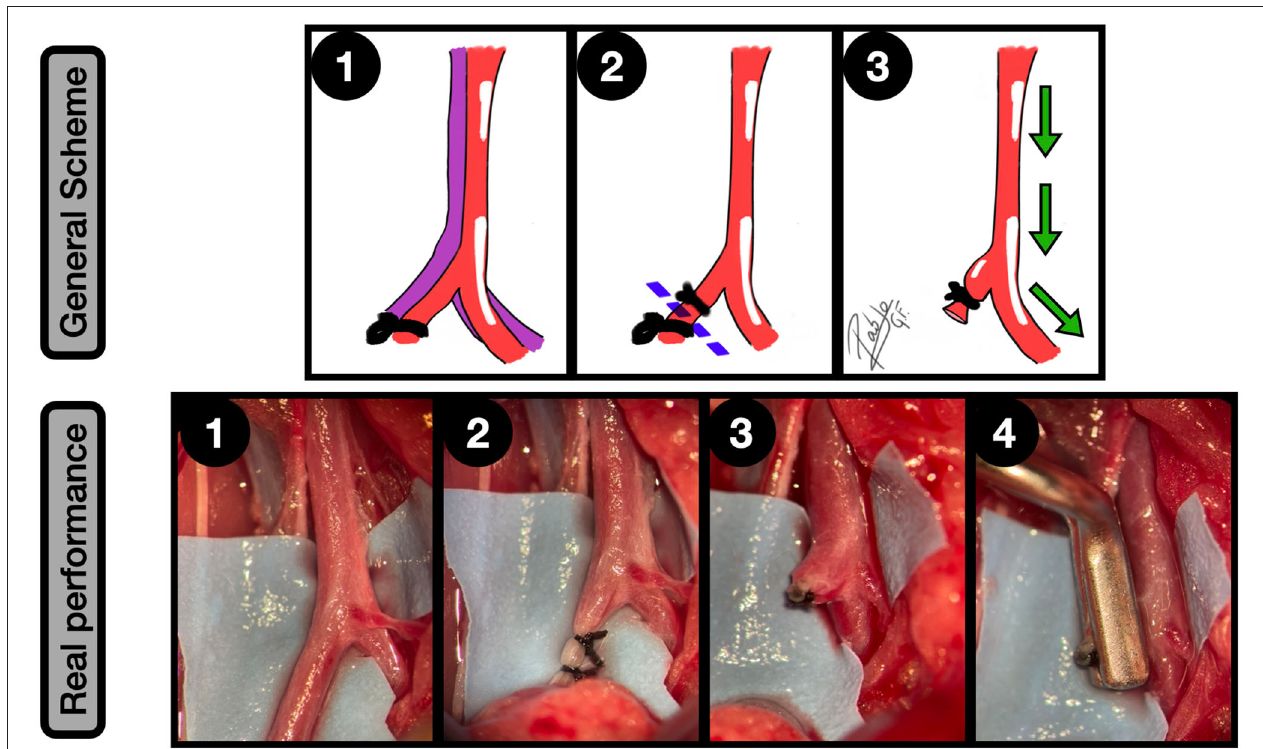
FIGURE 6 | Terminal branch occlusion model. General scheme: 1: AIB is dissected from the cava and one of the common iliac arteries is ligated; 2: The common iliac artery is sectioned between the two ligatures, closed to the bifurcation; 3: The remaining branch of the common iliac artery simulates a sidewall aneurysm while the aorta and contralateral common iliac artery become the parent vessel. The green arrows indicate the blood flow direction. Real performance: AIB and right common iliac dissection and exposure; 2: Left common iliac artery ligation in 2 points, with 6/0 silk. The proximal ligature must be placed close to the aortoiliac bifurcation AIB as is shown; 3: Common iliac artery section. A sidewall aneurism is obtained, acting the aorta and the contralateral common iliac artery as a parent vessel; 4: The aneurysm is